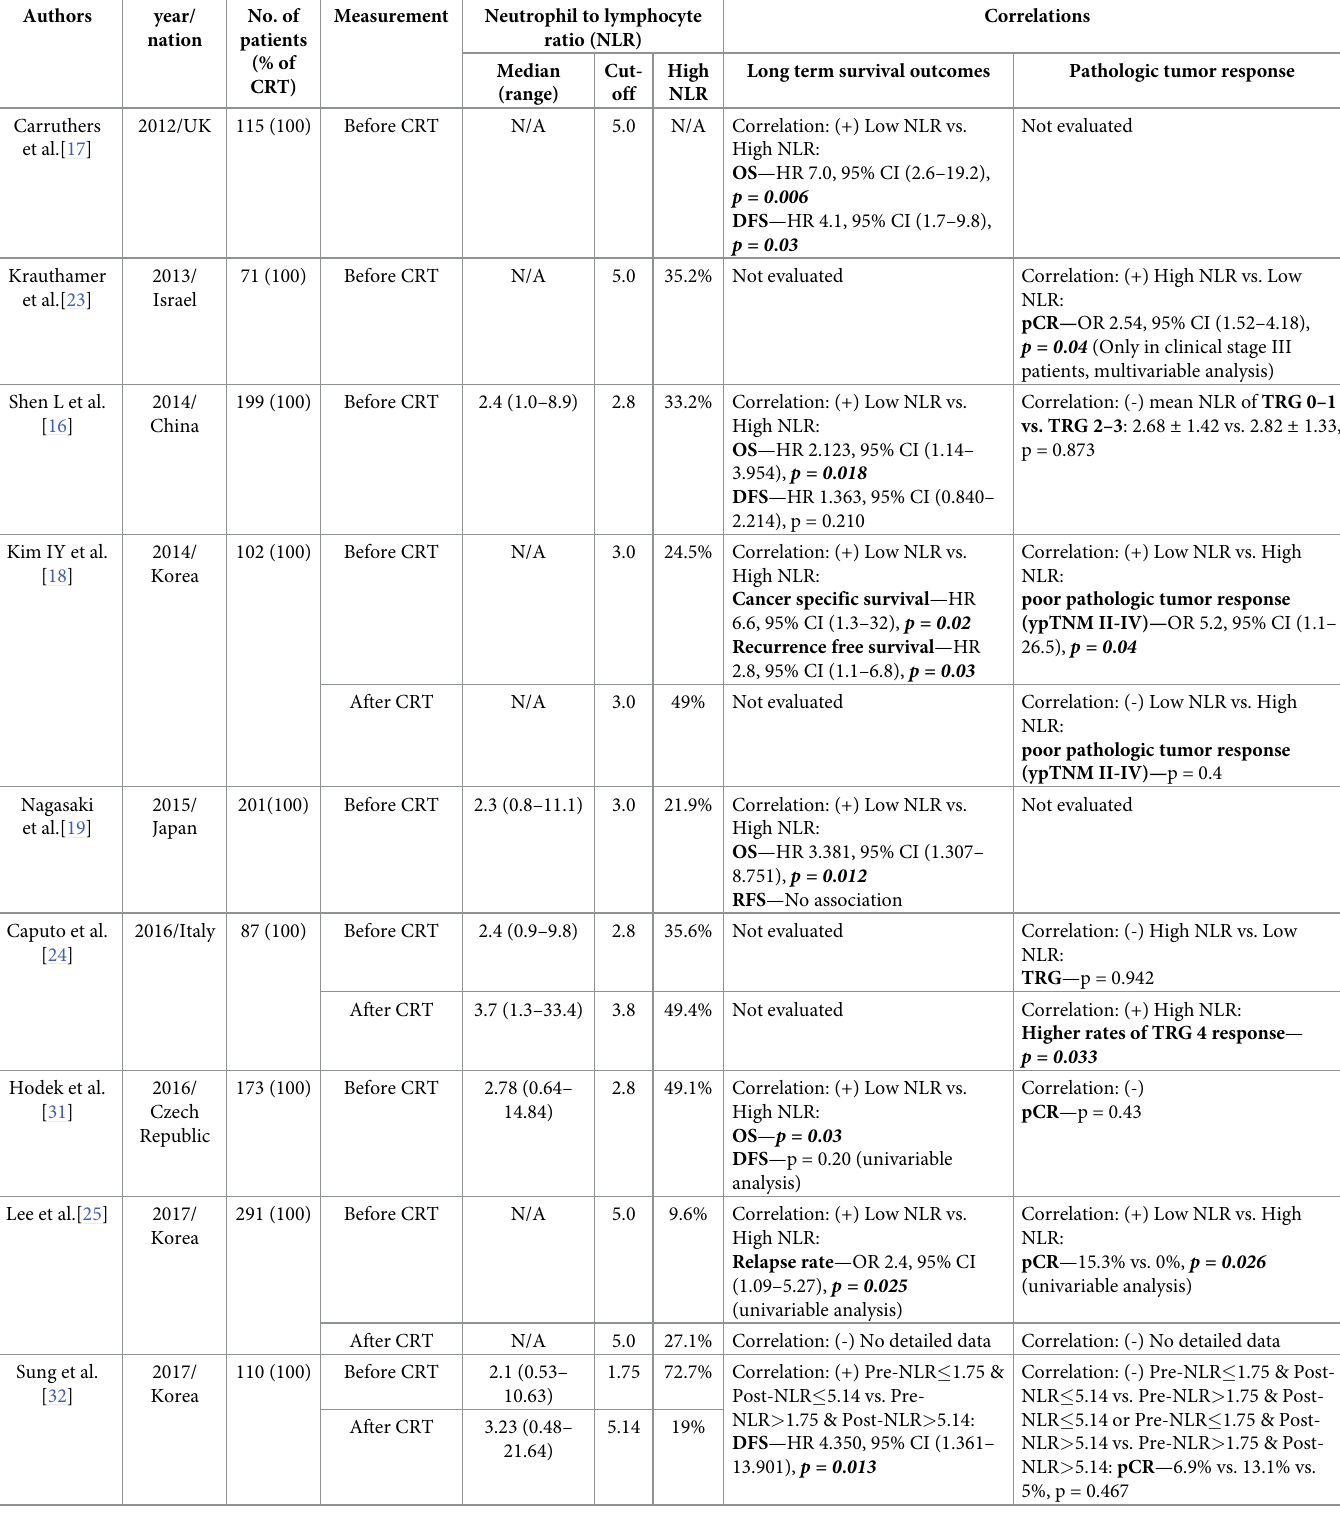
Table 4. Results of previous studies on NLR in rectal cancer patients with or without preoperative